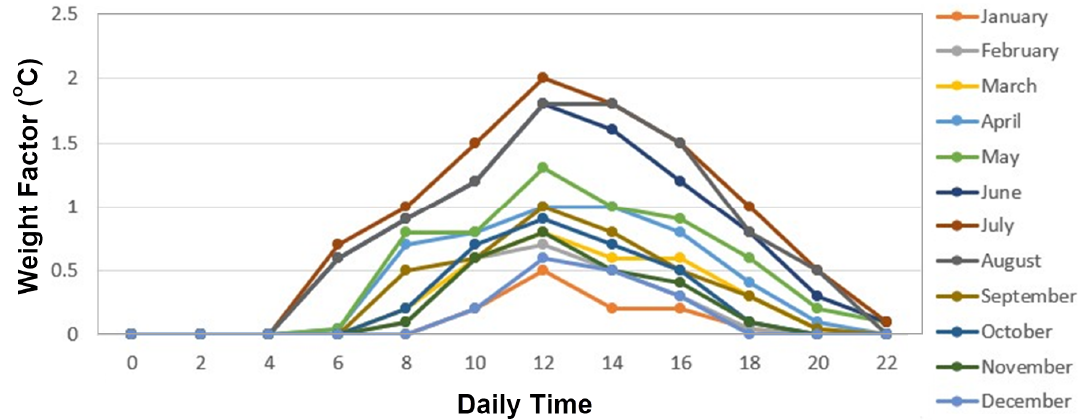
Figure 8. Monthly / hourly averaged weight factors of solar irradiation e ff ects on the increased cooling Figure 8. Monthly/hourly averaged weight factors of solar irradiation effects on the increased cooling demand of the buildings. demand of the buildings.